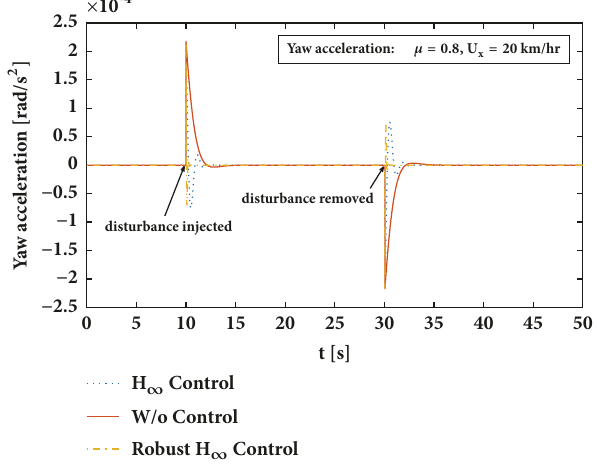
Figure 5: Yaw acceleration: 𝜇 = 0 .2; vehicle speed: 120 km / hr.